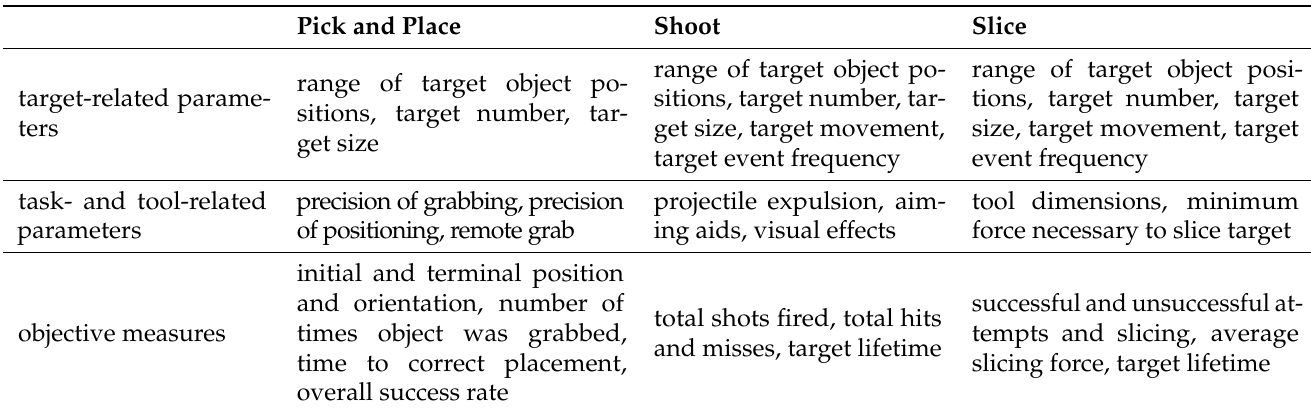
Table 1. Examples of configurable parameters and collected measures included in the prototype platform for the evaluation of VR interaction mechanics